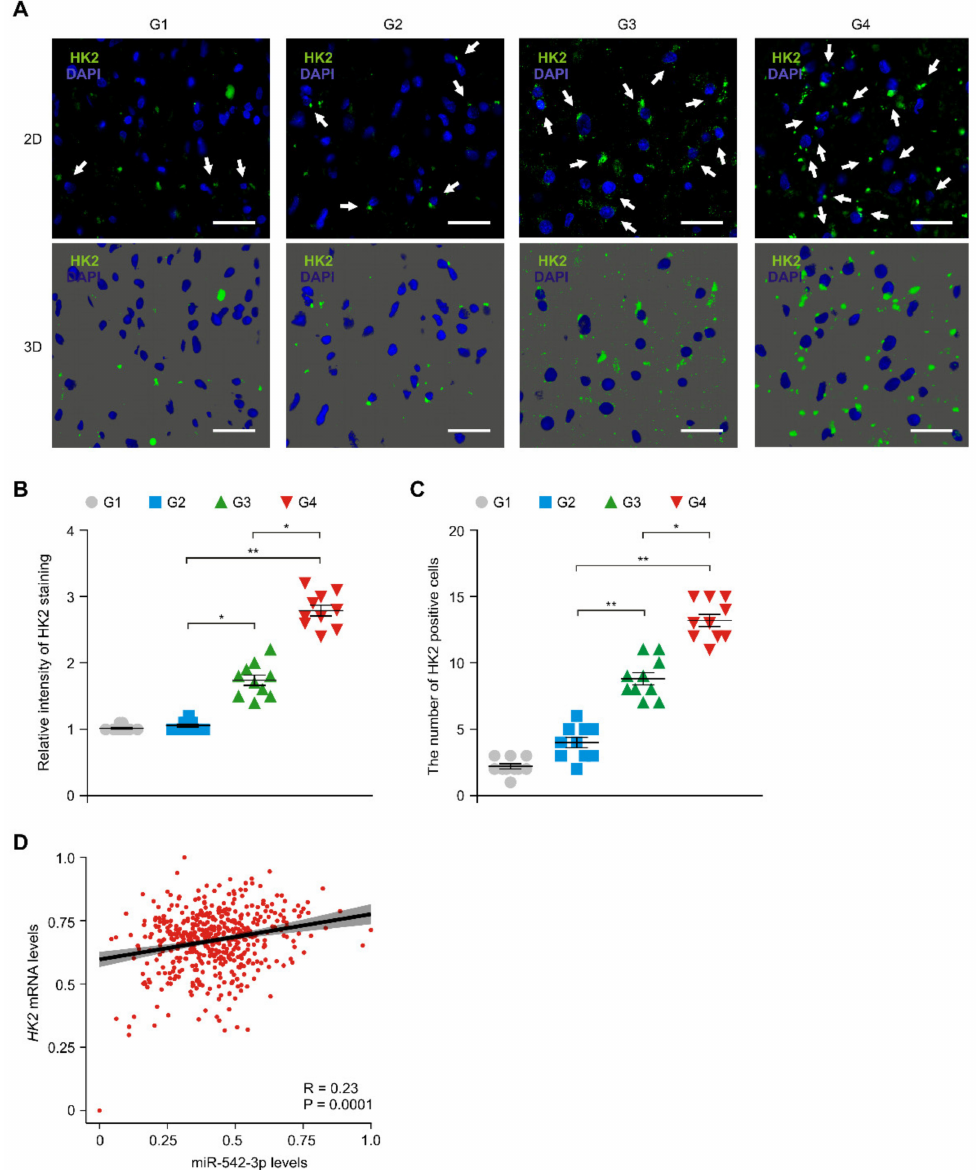
Figure 4. The levels of HK2 were elevated and were positively correlated with the levels of miR-542-3p in patients with gliomas. ( A ) Representative immunofluorescence 2D (top) and 3D (bottom) images of HK2 protein expression in glioma cells of tissues from patients with low- and high-grade gliomsa (G1, G2, G3, G4) showing HK2 (green) in glioma cells ( n = 10 images per individual subject, n = 3 per group). Blue indicates DAPI-stained nuclei in cells. Scale bars, 20 µ m. White arrows indicate HK2 positive cells. ( B ) Quantification of relative HK2 positive staining from immunofluorescence images in tissues from patients with low- and high-grade gliomas (G1, G2, G3, G4) ( n = 10 images per individual subject, n = 3 per group). Data are mean ± SD. **, p < 0.01; *, p < 0.05 by Student’s two-tailed t -test. ( C ) Quantification of HK2 positive glioma cells from immunofluorescence images in tissues from patients with low- and high-grade gliomas (G1, G2, G3, G4) ( n = 3 per group, n = 10 per area of individual subject). Data are mean ± SD. **, p < 0.01; *, p < 0.05 by Student’s two-tailed t -test. ( D ) A Spearman correlation coefficient analysis and linear regression analysis to determine the relationship between HK2 and miR-542-3p in patients with gliomas in the GBM and LGG datasets from the TCGA. Data are mean ± standard deviation (SD). R = 0.23, p = 0.0001 by Spearman correlation coefficient